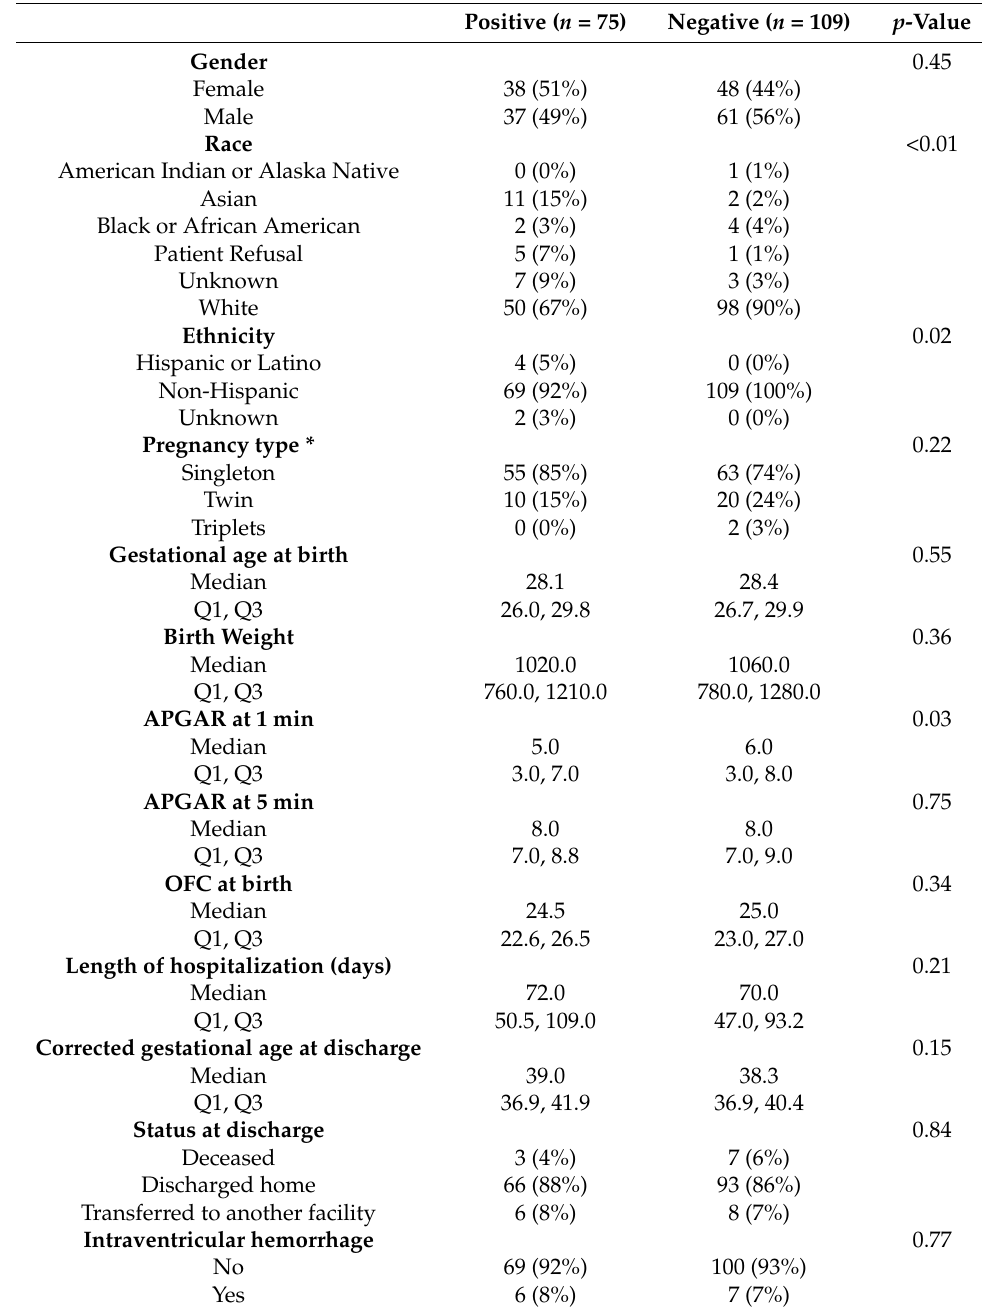
Table 3. Characteristics of infants receiving breast milk from mothers with DNAlactia (positive) and without CMV DNA in breast milk (negative), using infant as unit of analysis. Fisher’s exact test was used for categorical variables; Mann–Whitney–Wilcoxon used for continuous